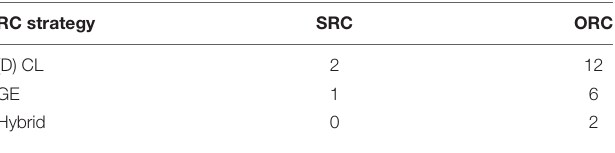
TABLE 4 | Distribution of target RCs produced across relativization strategies and RC types. RC strategy SRC ORC